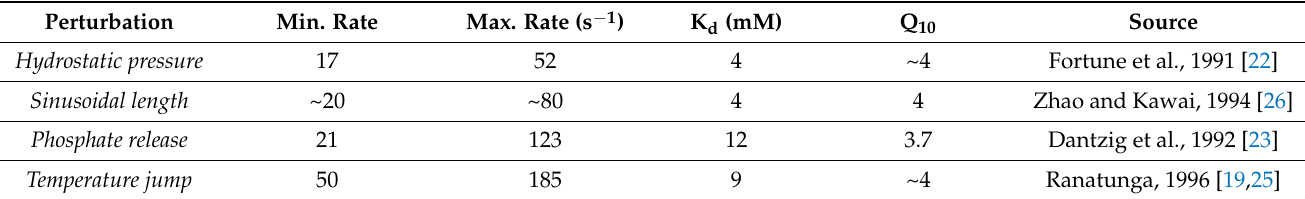
Table 1. Effects of phosphate (Pi) on force generation in skeletal